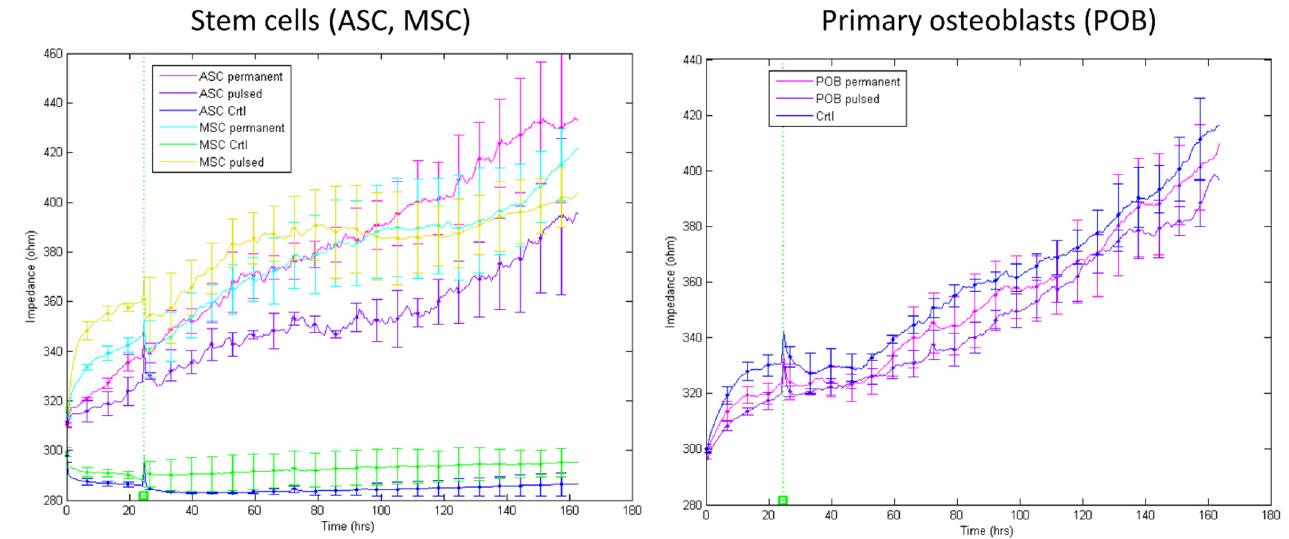
Figure 3. Impedance measurements at 16 kHz after three days of electrical stimulation. Impedance was measured in non-stimulated, pulsatile, and continuously electrically stimulated ASCs, BMSCs ( left ), and POBs ( right ). At t = 0 h, cells were seeded on the chips. Medium changes occurred every two days (mean ± SD, n = 3–5).